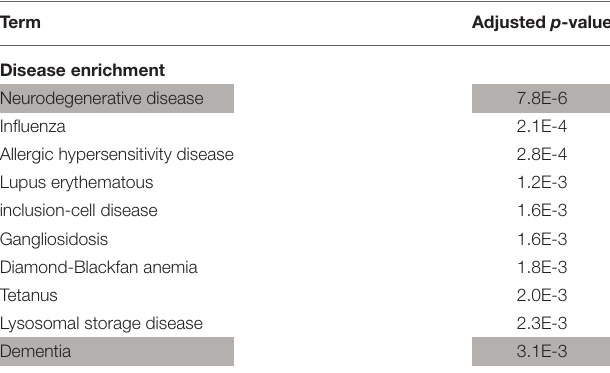
TABLE 7 | Enrichment analysis of the whole list of parent proteins giving rise to endogenous peptides binding HLA-DRB1 1501-encoded MHC class II molecules in the human B-cell